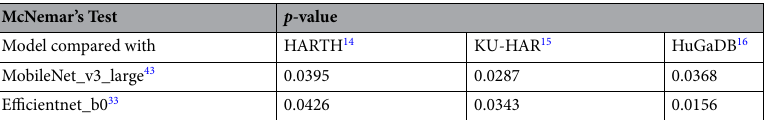
Table 10. Results of the McNemar’s test conducted on MobileNet_v3_large and Efficientnet_b0 transfer learning models: In every situation, the null hypothesis is